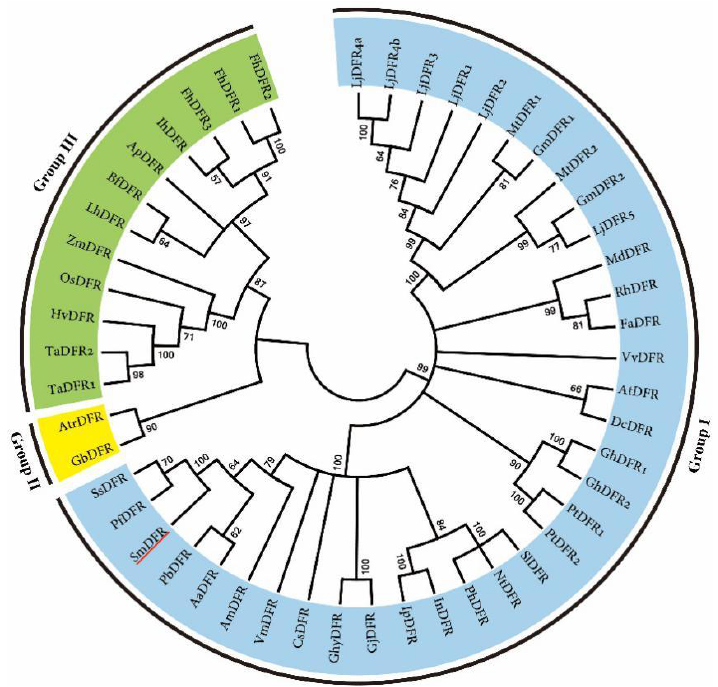
Figure 7. The phylogenetic relationship of DFR proteins. DFR amino acid sequences from various plant species were obtained from NCBI under the accession numbers listed in Supplementary Table S8 online.